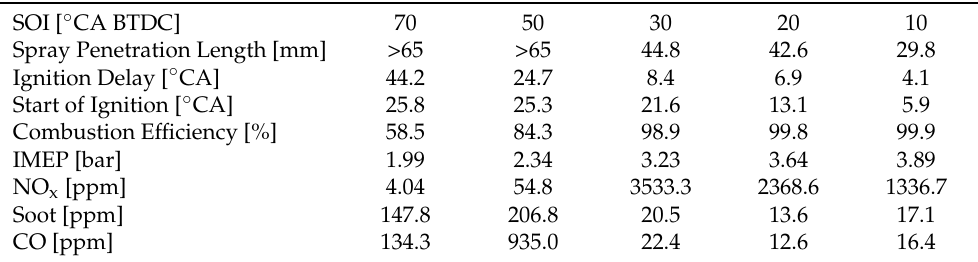
Figure 22. Time histories of soot mass fraction contour plot in a plane formed by the cylinder axis and a spray axis according to °CA after SOIgn for various SOI timings. Table 6. Effects of SOI timing on spray, combustion characteristics, and engine-out